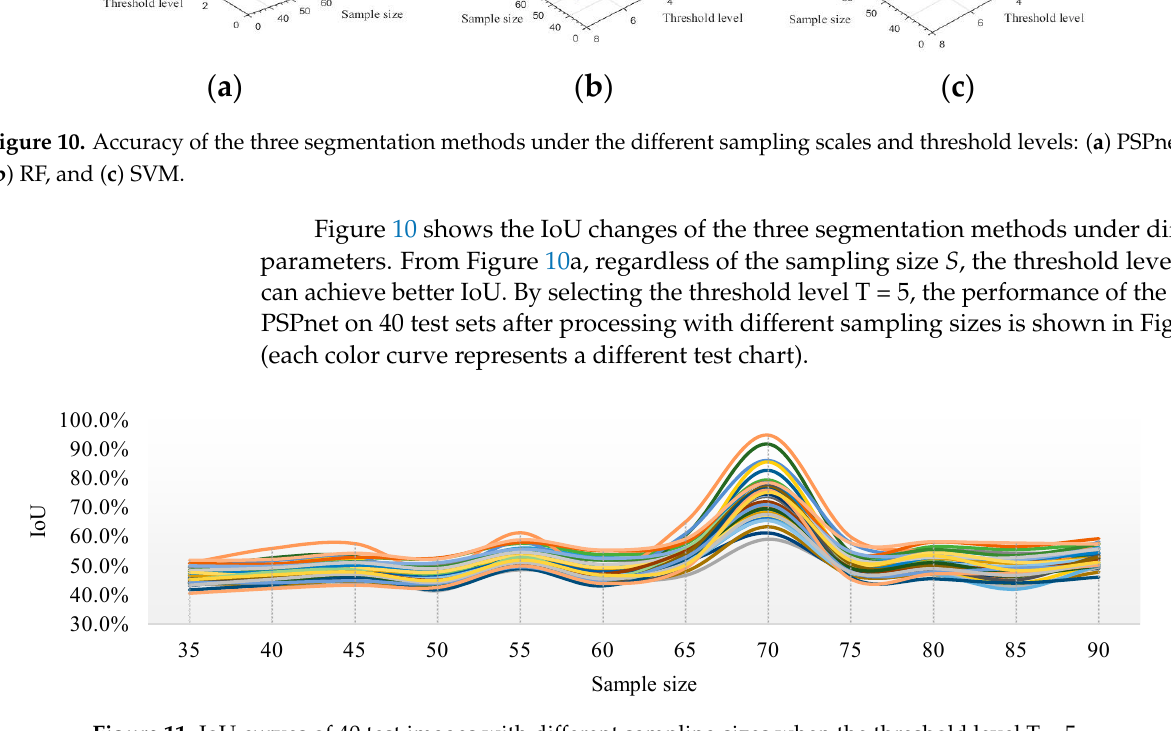
Figure 12. Threshold level T = 5, sampling size S = 70 pixels, test set image true value pixel, and the predicted pixel number change curve. 4. Discussion 4.1. Advantages and Limitations of the Model In this study, an effective model (PLD-M) for kiwifruit orchard data acquisition from low-altitude UAV remote sensing images is proposed. This includes the detection and segmentation of kiwifruit vines, and the prediction of the possible canopy distribution. The use of a deep learning method increased the quality of the segmentation image, and intersection and union ratio, compared to those of traditional machine learning. The ex- isting methods of dense tree canopy recognition and extraction can only obtain the num- ber of fruit trees, canopy parameters, and other information. In contrast, the PLD-M model can not only count and locate kiwifruit plants, but also extract the vine distribution and possible canopy distribution of each plant. Compared with the apple branch extraction model proposed by J Wu et al. (2020), PLD-M can not only obtain the specific distribution of vines and the position of plants, but also extract the distribution density gradient of liana plants. The distribution range of the canopy is more refined, and the hollow area of the canopy caused by the external polygon of branches is avoided. Due to the small size of the ground stump, camera lens distortion, and pan tilt stabil- ity, small distortions appear in the stitching process, which may cause tiny inconsistencies in the texture of different regions. In subsequent research, these problems could be ad- dressed by improving the resolution of the remote sensing camera, using a lens with less distortion, and enhancing the pan tilt stability. In this paper, we do not discuss the gap between the proposed PSPnet and other deep learning networks, such as that of Lucas Prado Osco et al. [28]. This is because, compared with the recognition of large areas, the mAP of deep learning network is not superior to traditional machine learning in the classification of kiwifruit vines. However, this study